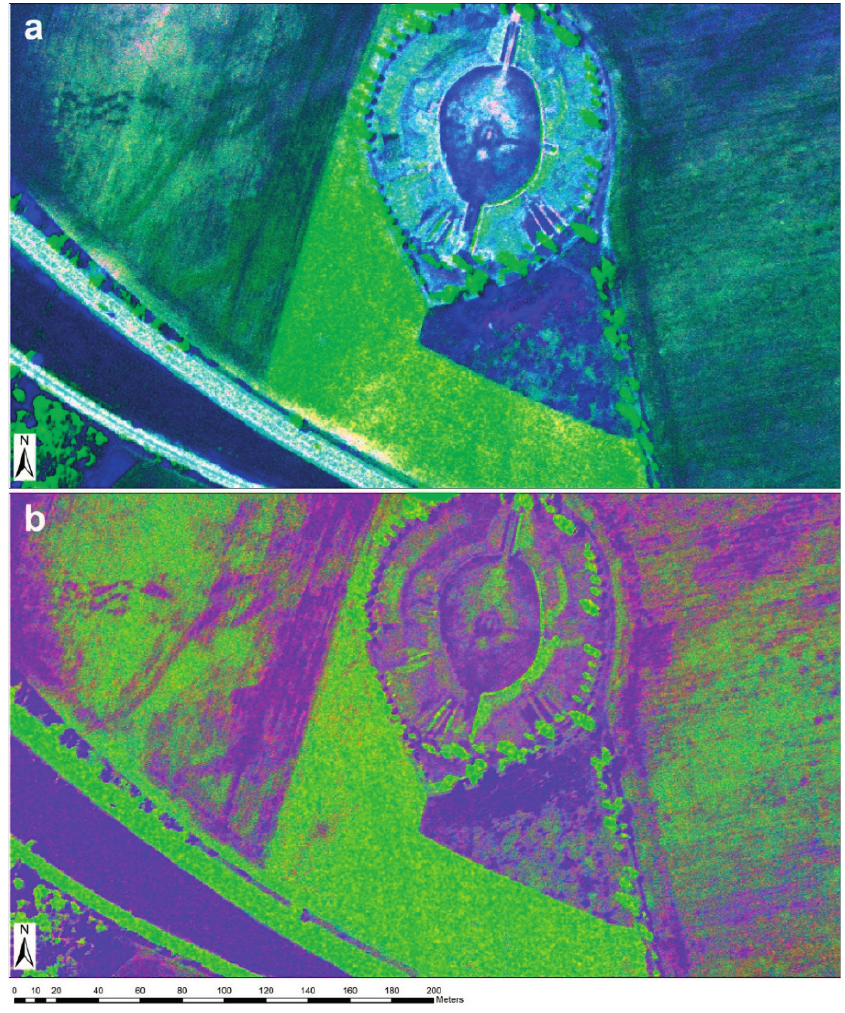
Figure 9. Inflection point from smoothed data ( a ) calculated between bands 30 and 40 (green peak, 560–618 nm); ( b ) between bands 80 and 95 (852–912 nm) in the vicinity of a water absorption band at around 980 nm. Each image is a false color composite of the three REIP outputs provided by ARCTIS (same order of REIP indices as in Figure